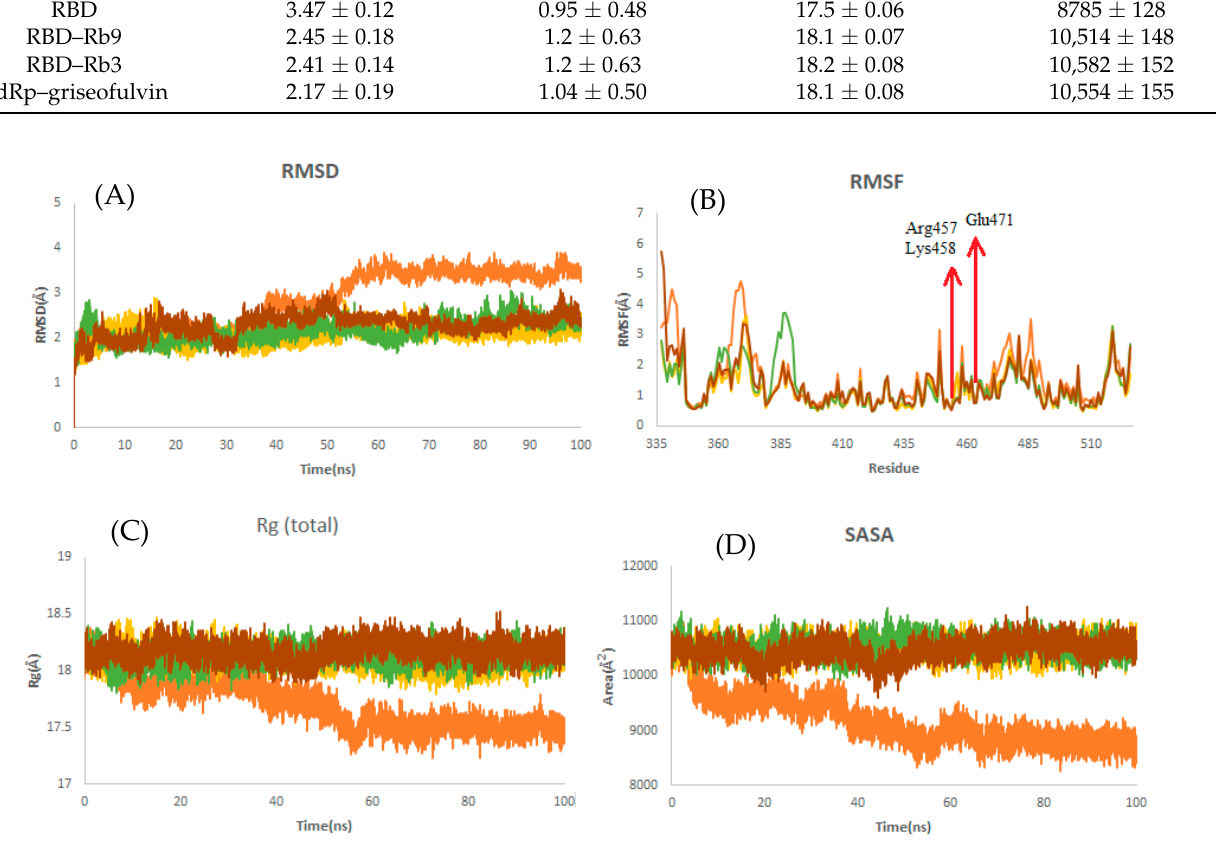
Figure 6. Structural dynamics of RBD. ( A ) Root mean square deviation (RMSD), ( B ) root mean square fluctuations (RMSF), ( C ) radius of gyration (Rg) plot, and ( D ) solvent-accessible surface area (SASA). Orange color indicates RBD-free form; yellow, green, and brown indicate RBD in a complex with griseofulvin, Rb9, and Rb3, respectively. Table 5. The average of RMSD, RMSF, Rg, and SASA for RBD during the last 20 ns of MD simula- tions. PubChem IDs of derivatives Rb9 and Rb3 are 125429633 and 56950846, respectively.